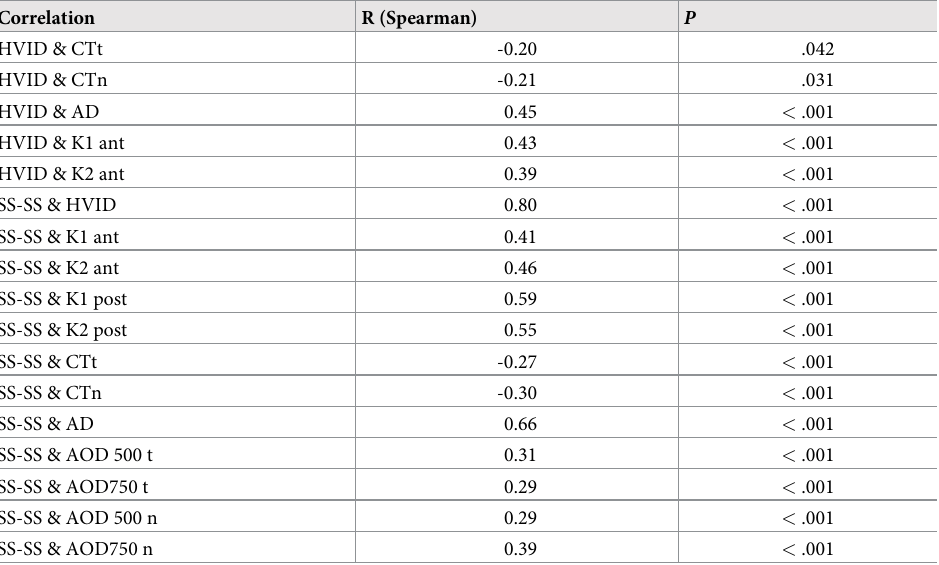
Table 3. Statistically significant correlations of HVID and SS-SS with other anterior segment parameters.